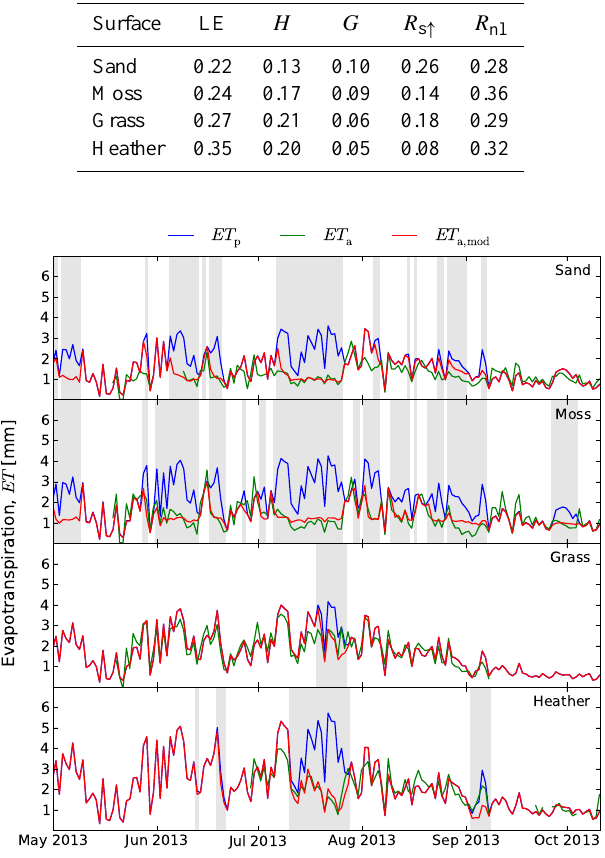
Figure 9. Measured and modeled daily ET for the four lysimeters. Gray bars indicate time periods where ET a,mod is smaller than ET p , i.e., when evapotranspiration was